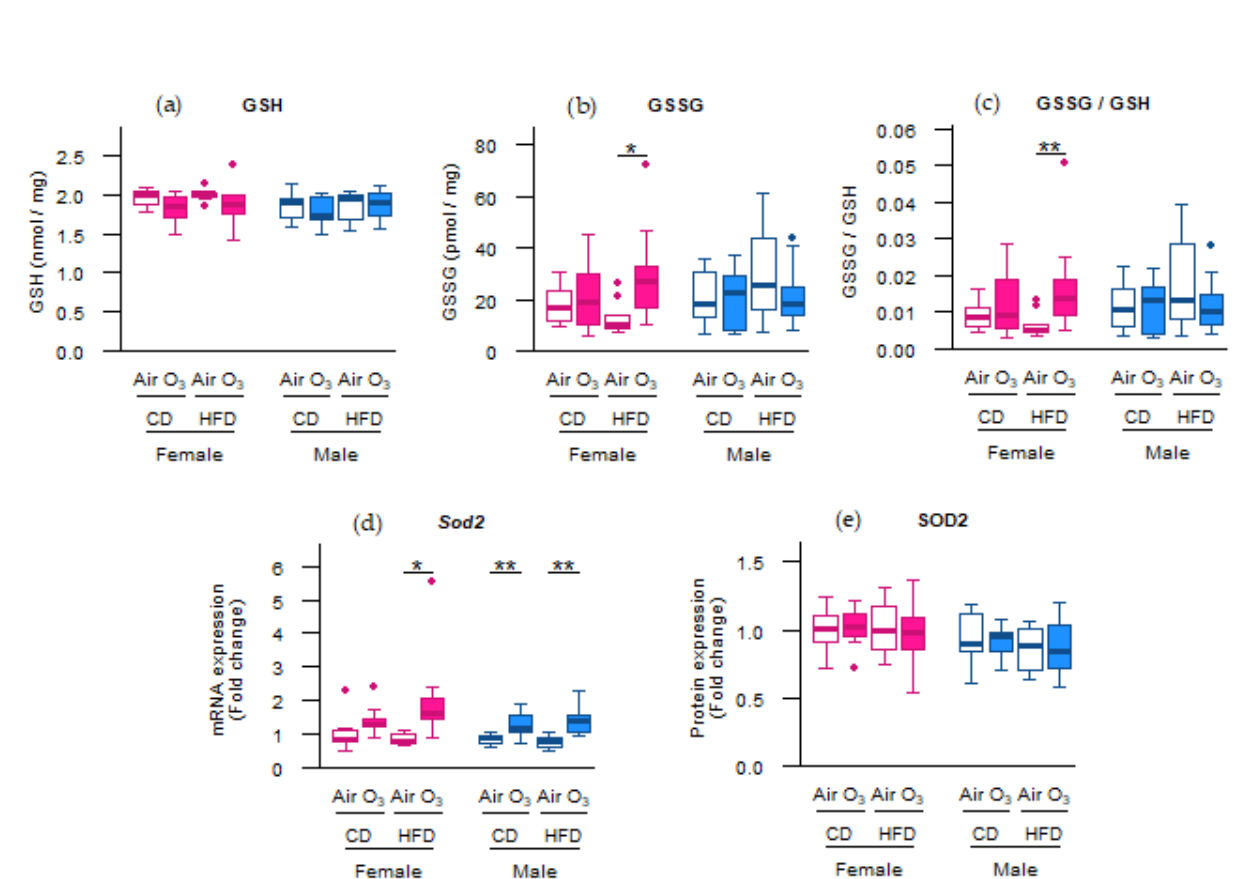
Figure 1. Acute ozone exposure increased pulmonary oxidant status in female offspring from high-fat diet (HFD) dams and all male offspring. ( a ) Reduced glutathione (GSH), ( b ) oxidized glutathione (GSSG) and ( c ) GSSG/GSH ratio, ( d ) Sod2 mRNA expression, and ( e ) SOD2 protein expression were assessed within two hours after exposure to filtered air or ozone in the lungs of female and male offspring from dams fed a perinatal control diet (CD) or HFD. Data are presented as boxplots. Statistical analysis by two-way ANOVA with a Holm–Sidak post-hoc test. n = 10 per group ( a – c ), n = 9–10 per group ( d ), or n = 7–10 per group ( e ). * p < 0.05, ** p < 0.01. O 3 —ozone. Table 1. Lung Sod2 mRNA levels correlated significantly with broncheoalveolar lavage fluid (BALF) vascular leakage markers albumin and total protein in female and male offspring from high-fat diet (HFD) dams. All of the markers were assessed within two hours after exposure to filtered air or ozone in the lungs or BALF from female and male offspring from dams fed a perinatal control diet (CD) or HFD. BALF albumin and total protein data were previously published [19]. Only significant correlations (q < 0.05) are shown in this table. The results from non-significant correlations are listed in Table S1. Statistical analysis by Pearson’s product–moment correlation after stratification for sex and diet. False discovery rate q-values were computed from p -values using the Benjamini–Hochberg procedure to correct for multiple testing. Correlation Stratum r q-Value